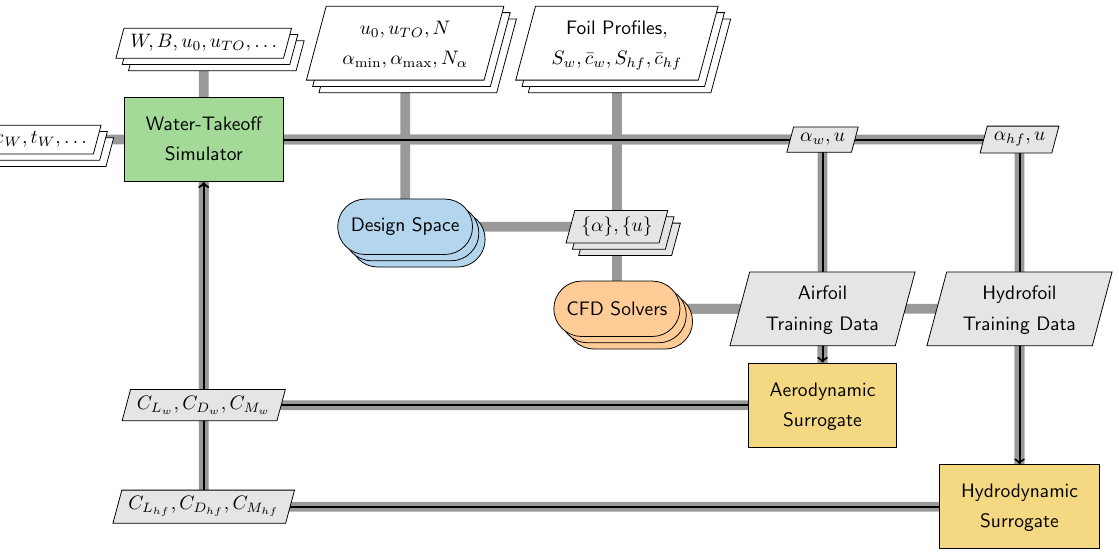
Figure 4. XDSM diagram for the water-takeoff simulator with surrogate